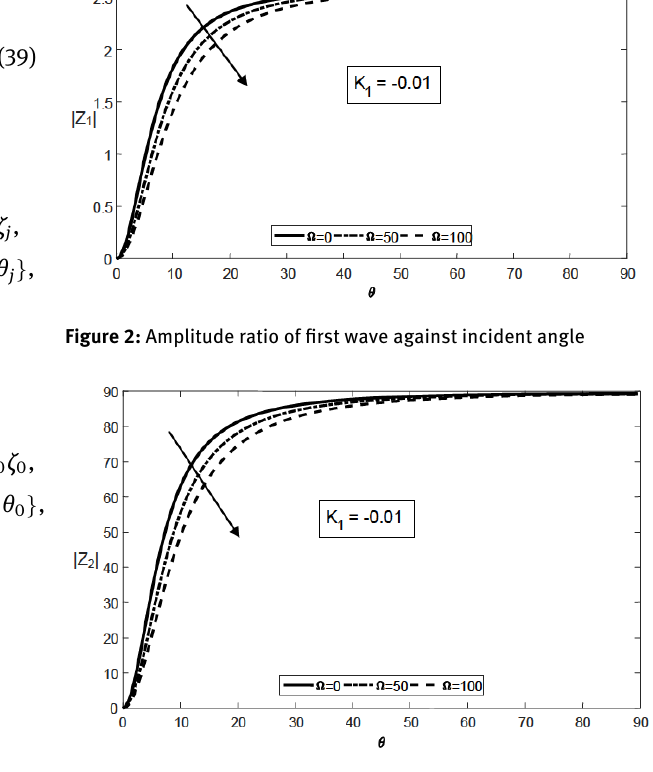
Figure 3: Amplitude ratio of second wave against incident